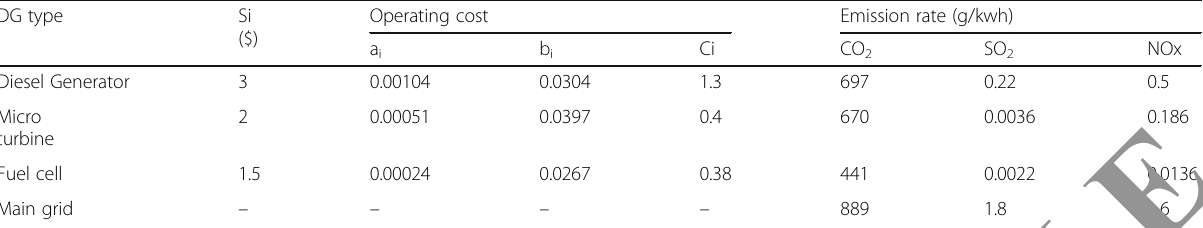
Table 2 Power cost and emission rate